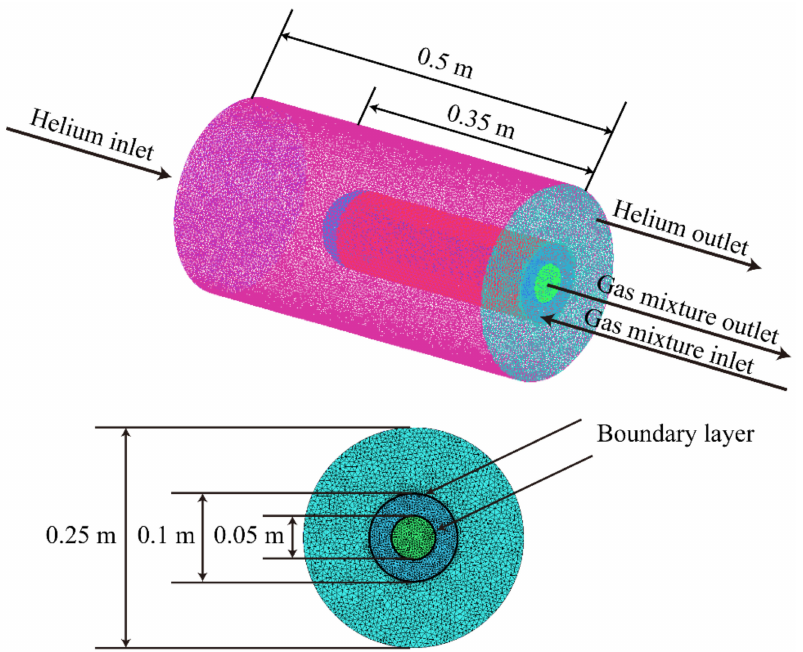
Figure 3. Meshing of the bayonet heat exchanger.